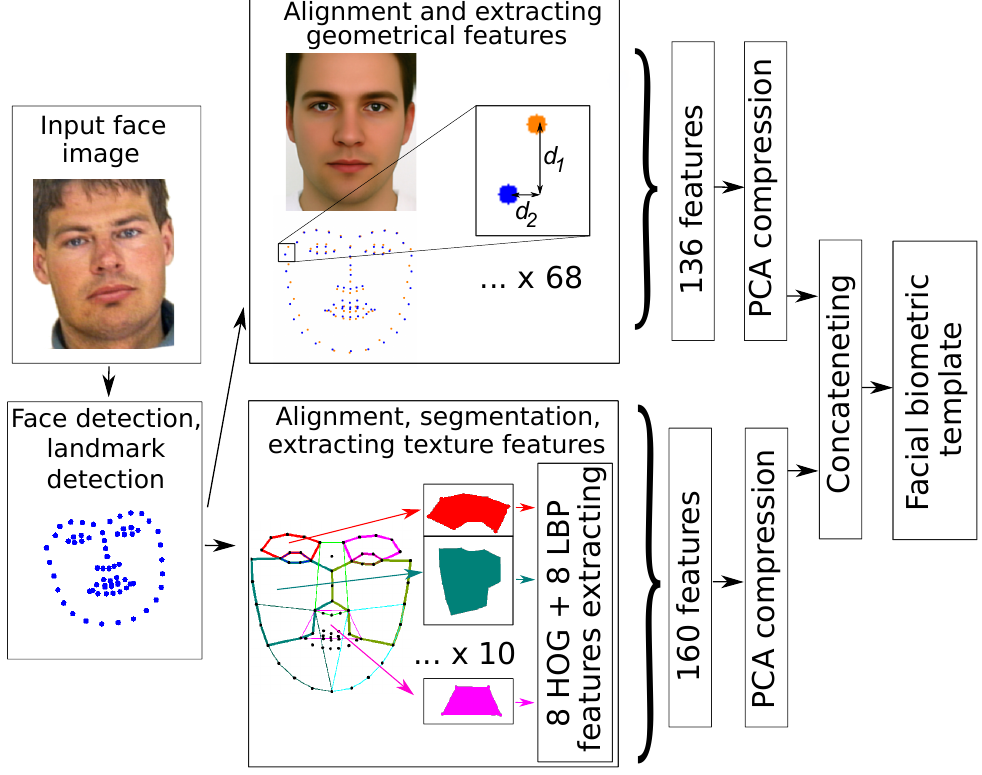
Figure 2. The process of extracting facial biometric template from the input face